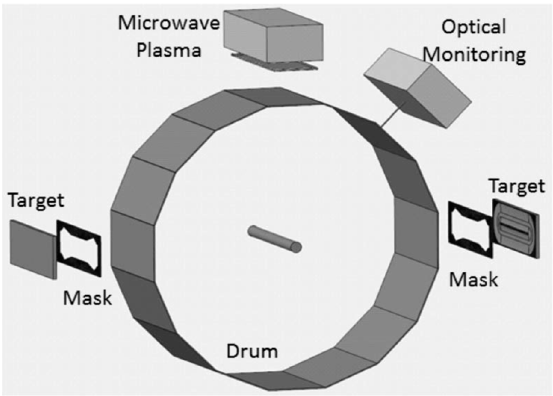
Figure 1. The schematic diagram of microwave assisted pulse DC drum-based sputtering system.